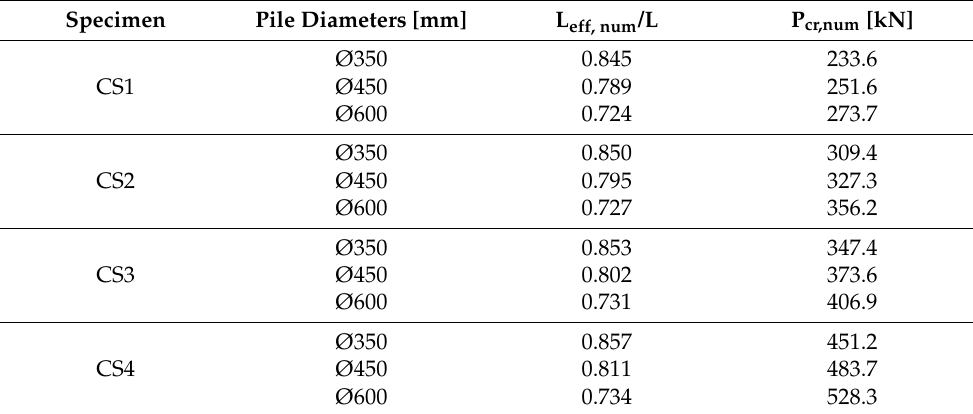
Table 6. Numerical results for the effective buckling length and buckling force for different pile diameters for the specimen CS1–CS4.